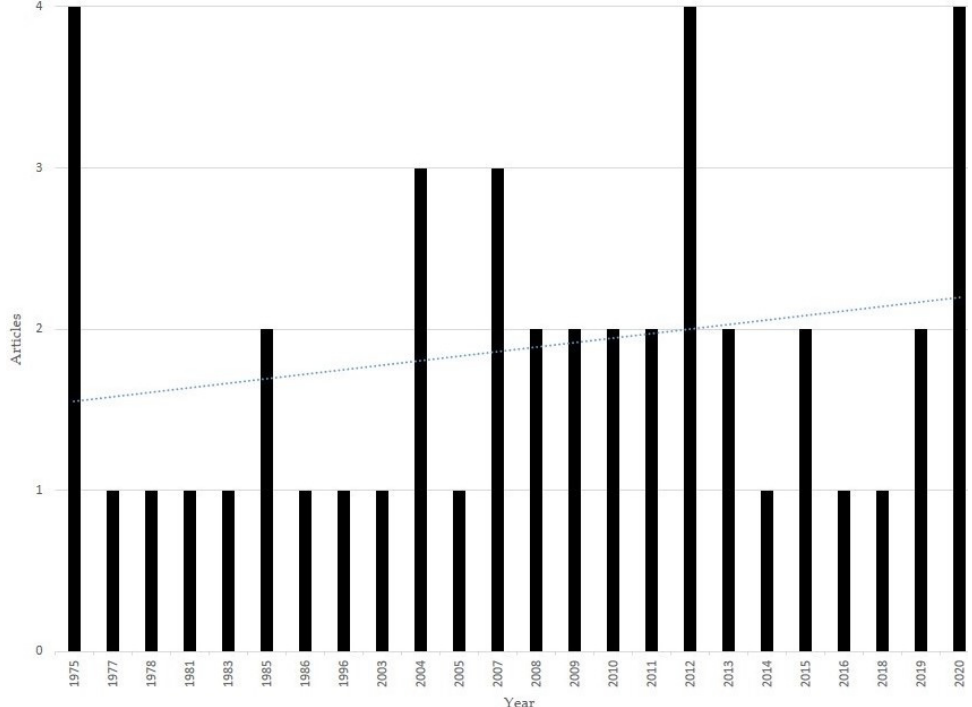
Figure 2. Caffeine/Attention Deficit Hyperactivity Disorder-related articles since 1975 (Source: MEDLINE).